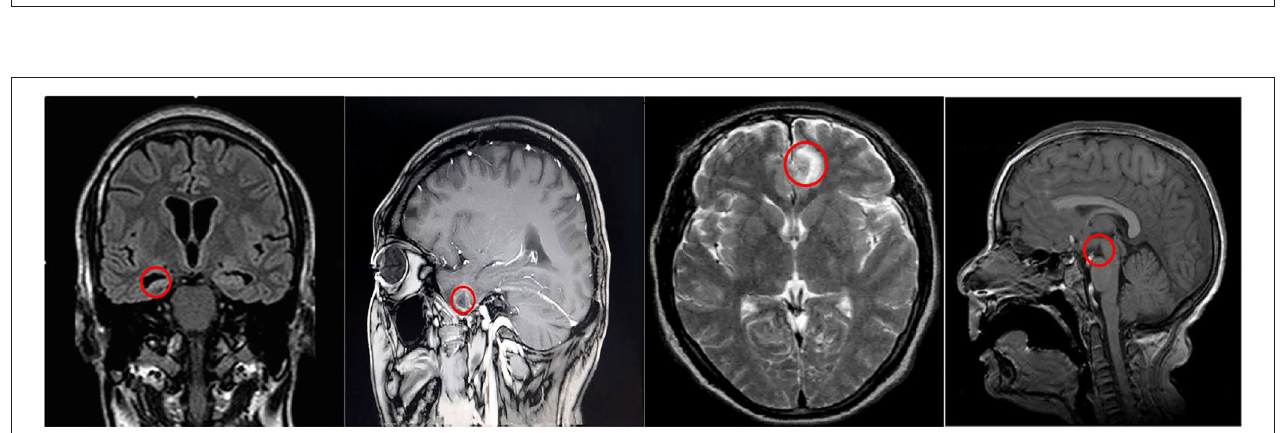
FIGURE 5 | MRI images of refractory epilepsy in children